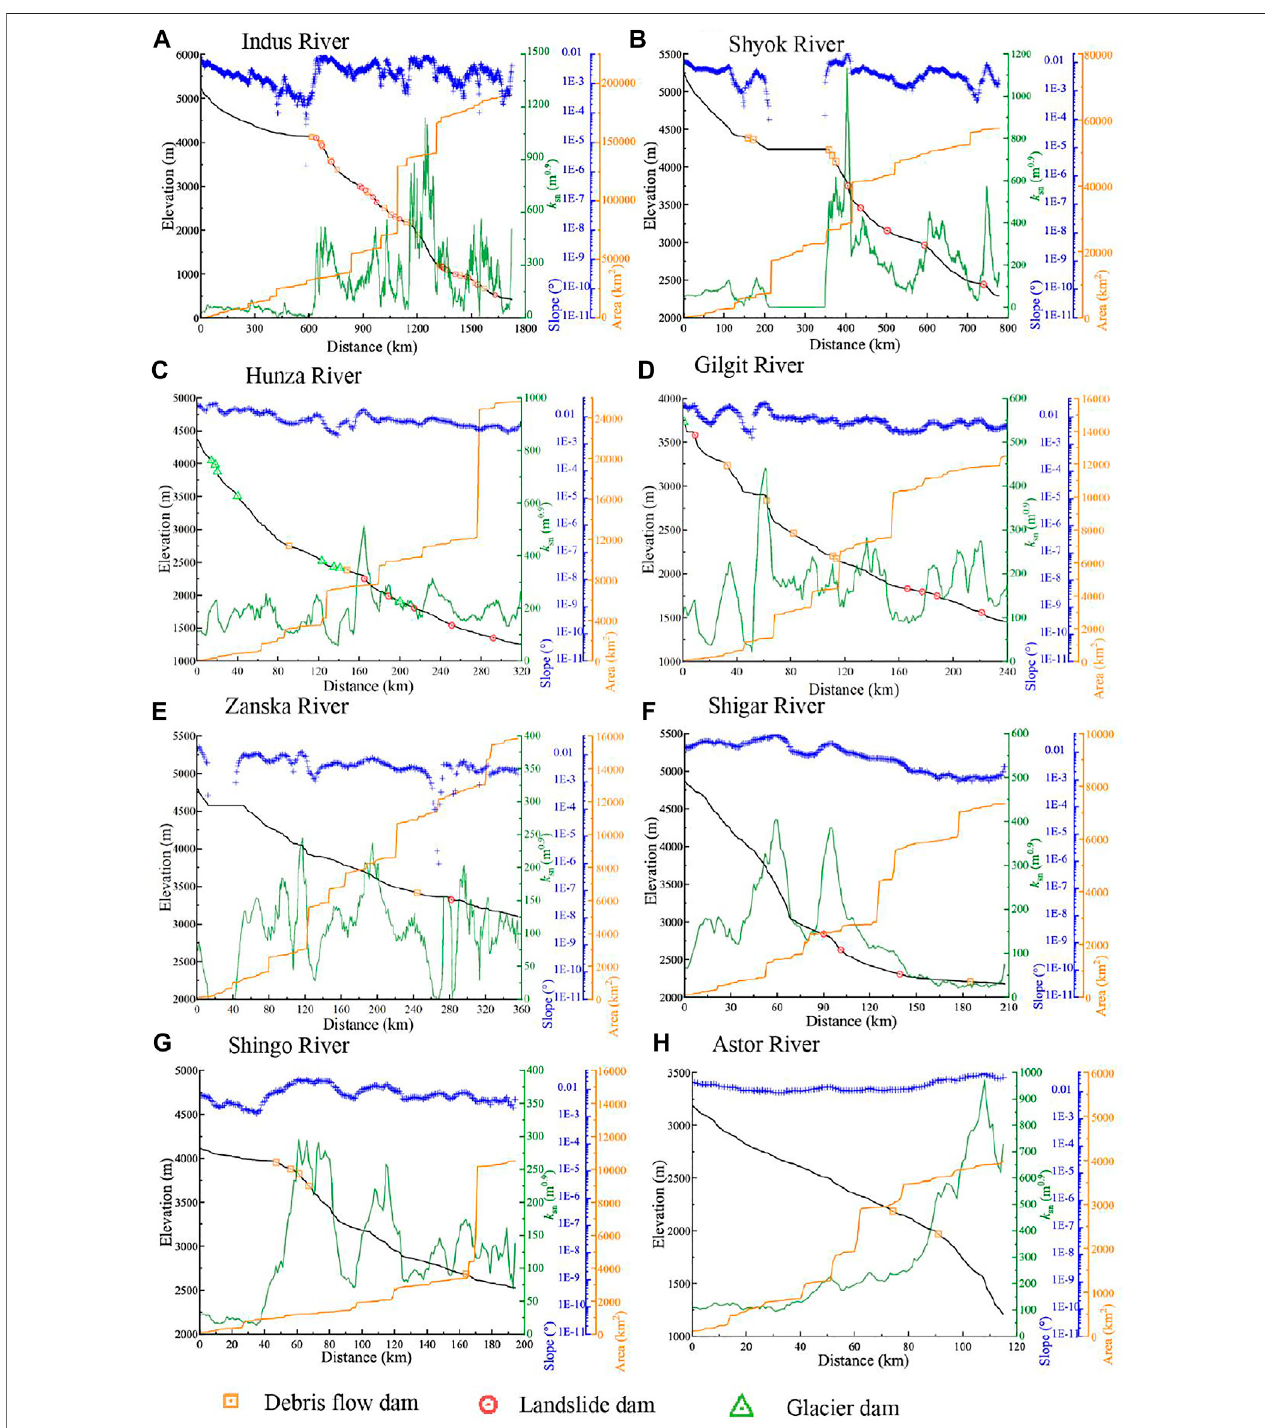
FIGURE 9 | Spatial relationships between dams and river longitudinal pro fi le in sub-basins of the upper Indus (see Figure 8 for locations). Each graph plots dam type (debris fl ow, landslide and glacier) on the long pro fi le (black line), with upstream area (orange), slope (blue) and steepness index (green), the slope and steepness index are smoothed on average for every 10 values.